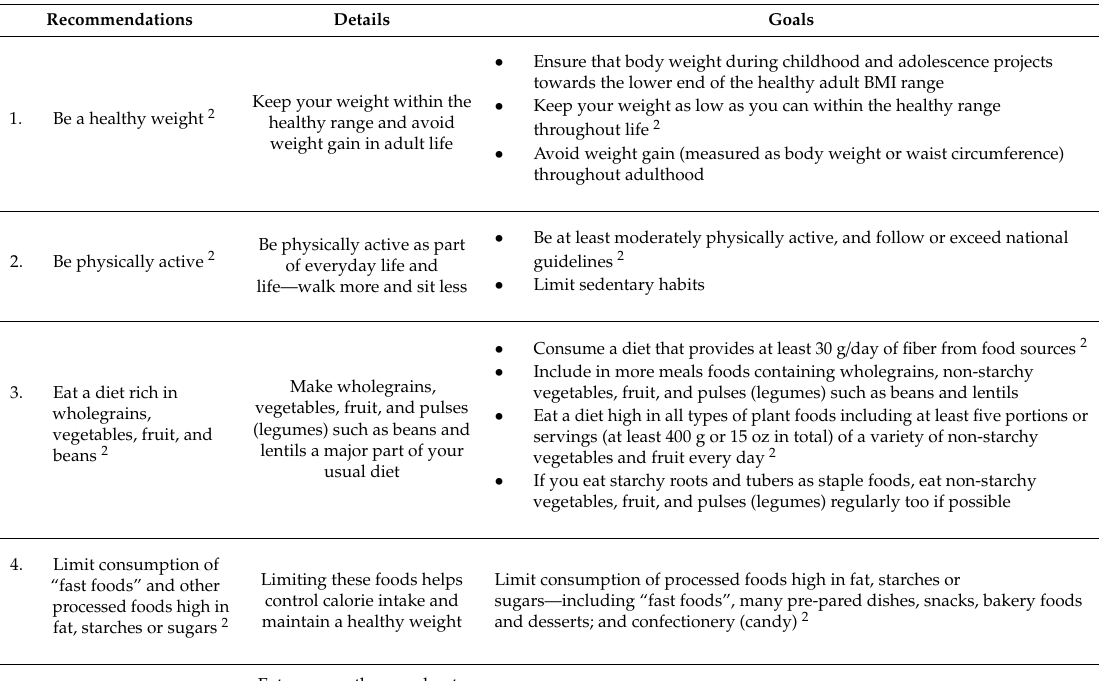
Table 1. The 2018 WCRF / AICR Recommendations for Cancer Prevention 1